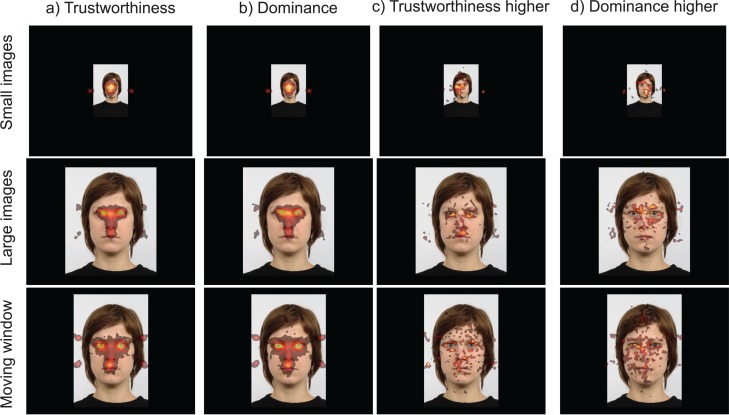
(A and B) Heatmaps of fixations across the three viewing modes (small images, larger images, moving window) and tasks (trustworthiness and dominance ratings); (C and D) difference maps showing where more fixations were made for trustworthiness ratings than for dominance ratings, and vice versa.